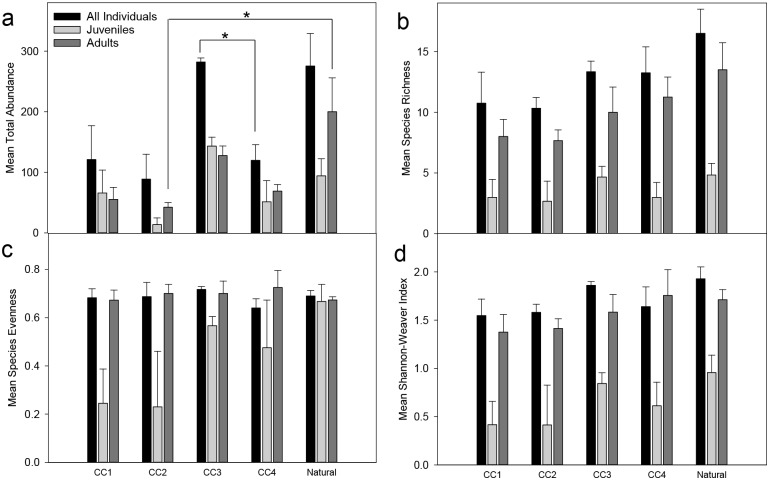
(a) Total abundances, (b) species richness, (c) species evenness, and (d) Shannon-Weaver indices of fish communities in varying reef categories in 2014.CC1: 1–30 culverts, CC2: 31–70 culverts, CC3: 71–120 culverts, CC4: 121–190 culverts, and Natural: naturally-occurring reefs. Error bars represent standard error (± 1). Asterisks (*) indicate significant differences (P > 0.05).